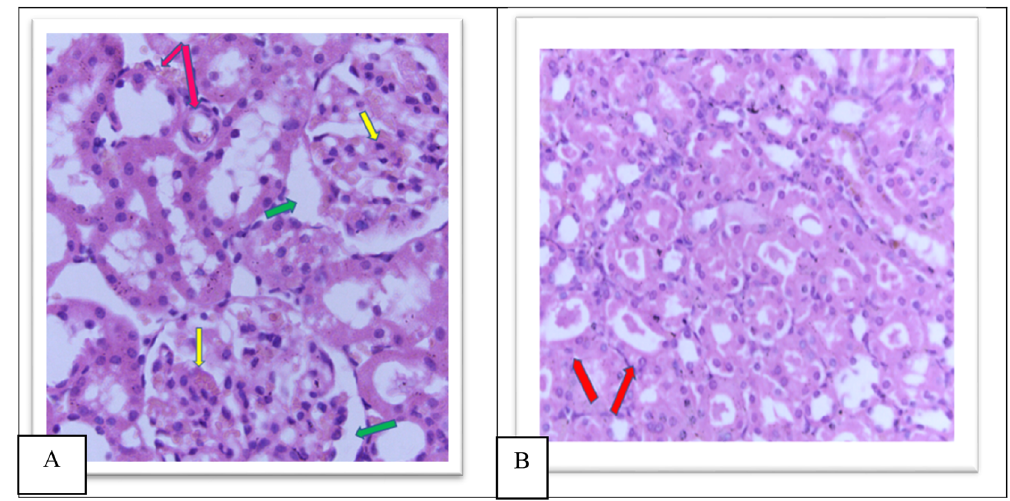
Figure9.A.Sectionofthekidneytissueofrat(GroupV)Showmoderatecongestionofinterstitial(Pinkarrow), moderate congestion of glomeruli (yellow arrow) and moderate increased of urinary space (Green arrow) (H&E, (cid:1) 40). B. The section of rat kidney tissue (Group V) shows a moderate tubular degeneration and a moderate formation of hyaline casts with in tubular lumens (red arrow) (H&E, (cid:1)